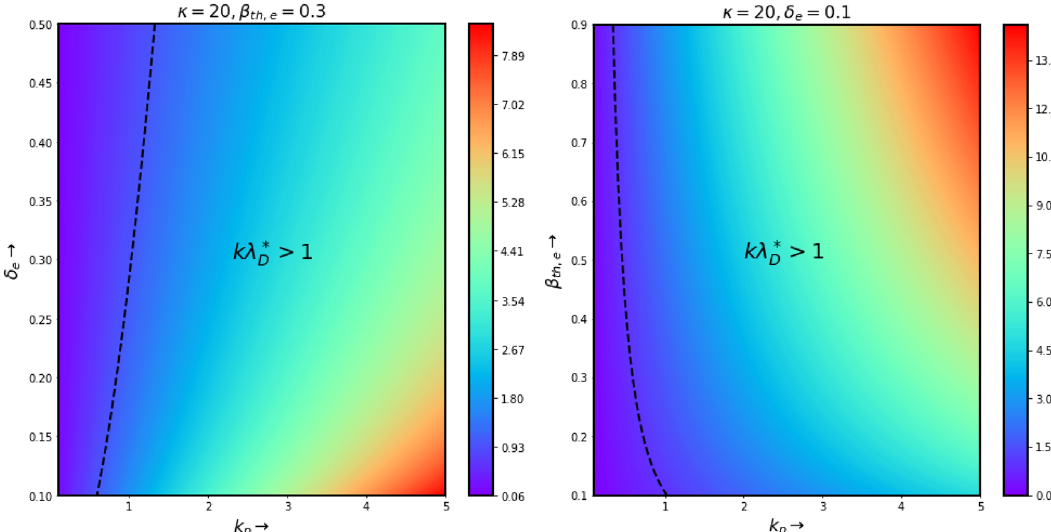
Figure 2. variation of k p (cid:31) ⋆ D for electrostatic waves in an electronegative plasma. Left: For different values of electron concentration and Right: For different values of electron thermal energy. Other parameters are kept constant as mentioned. The black dotted line represents k p (cid:31) ⋆ D = 1 electron populations on the dispersion curves, here in Fig. 2 we have shown the contour plots of k p (cid:31) ⋆ D . The color (cid:31) ⋆ 1 . The region where k > 1 is also represents the value of k p (cid:31) ⋆ D . The black dotted line is representing k p (cid:31) ⋆ D p D = marked (the right hand portion of the dotted black line). From the left panel, we see that for a fixed value of 1 straight line also moves towards the higher electron temperature, as the electron population increases, k p (cid:31) ⋆ D = k p values. At a specific electron concentration, for all the wave number values, which are on the left hand side of 1 line, will give rise to ion acoustic mode, whereas the higher wave numbers on the right hand side the k p (cid:31) ⋆ D = 1 line will lead to the generation of ion oscillations. On the other hand, for fixed values of electron of the k p (cid:31) ⋆ D = 1 curve shifts towards the lower wave number concentration, as the electron temperature increases the k p (cid:31) ⋆ D = values. It indicates that in an electronegative plasma the ion acoustic modes are more likely to be found for rela- tively smaller values of β th , e , so that k p (cid:31) ⋆ D remains << 1 . Later, we will study the dispersion curves for nonlinear amplitudes by measuring the wavelengths of the waves from the solution of equation of motion of the waves. In the next section we derive the equation of motion by assuming travelling wave approximation and present its numerical solutions in the nonlinear regime.